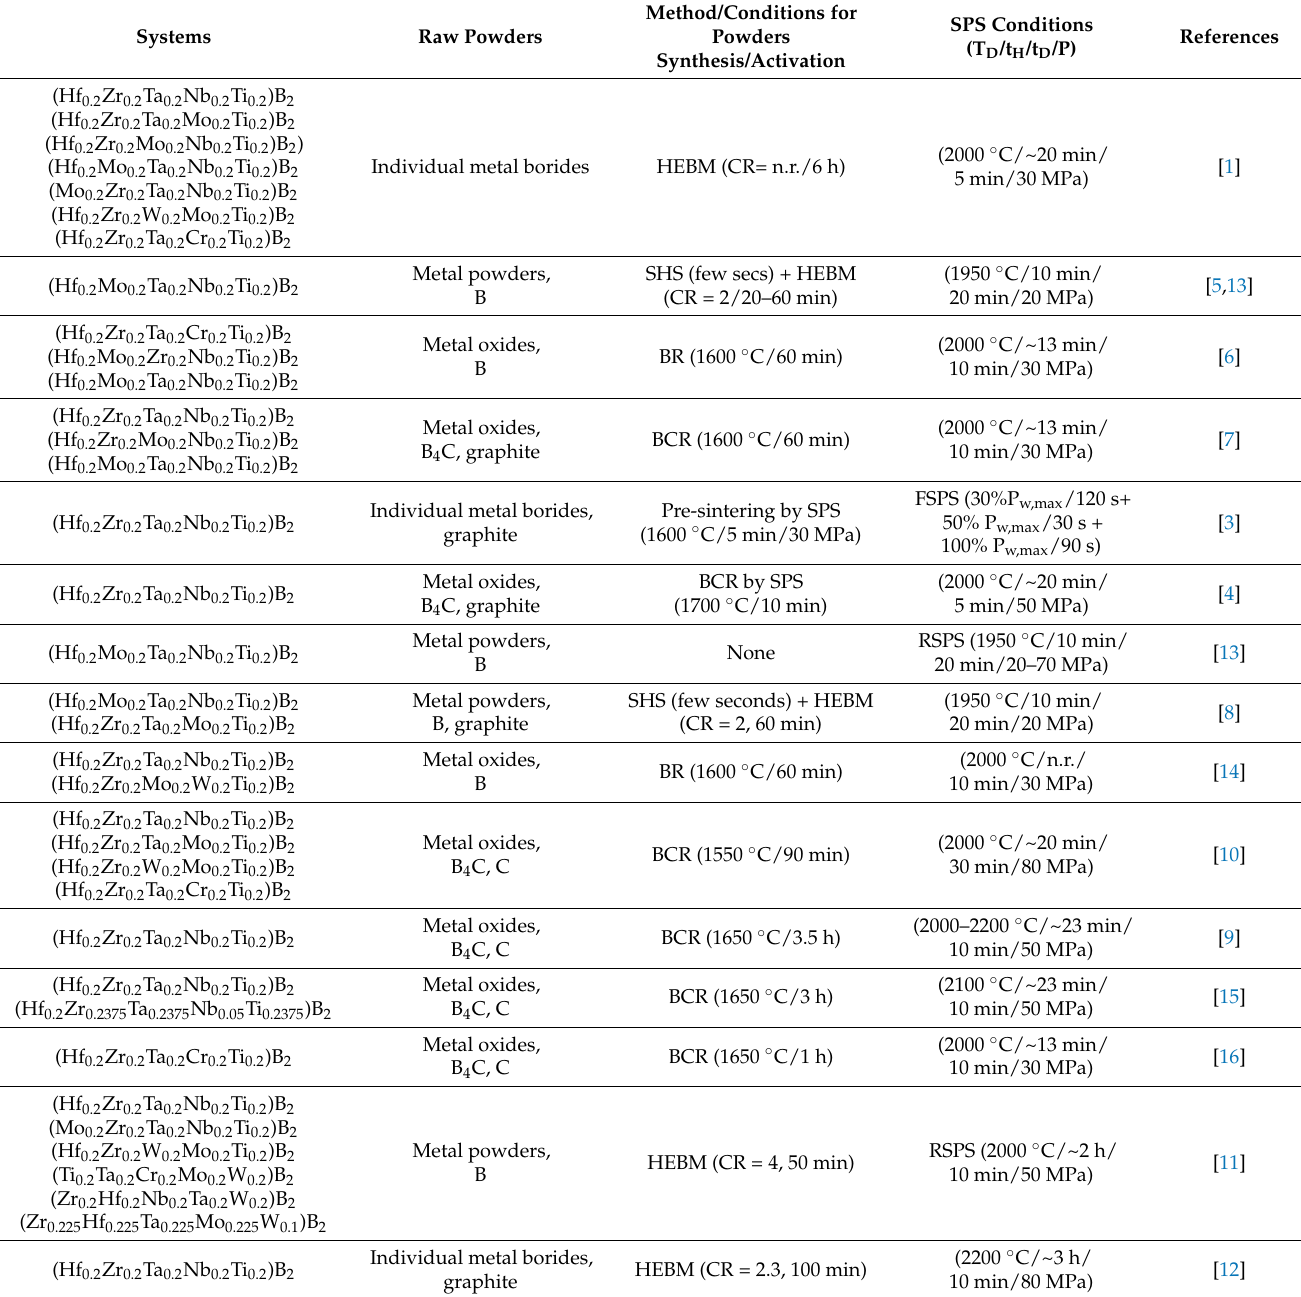
Table 1. Quinary high entropy metal borides (HEBs) obtained in bulk form by spark plasma sintering (SPS) with details on powder pretreatments and corresponding experimental conditions adopted (T D = dwell temperature, P = mechanical pressure, t H = total heating time to reach T D ; t D = dwell time at T D , P w,max = maximum electric power, CR = charge ratio; HEBM: high energy ball milling; BR: borothermal reduction; BCR: boro-carbothermal reduction; SHS: self-propagating high-temperature synthesis; RSPS: reactive SPS; FSPS: flash SPS; n.r. not